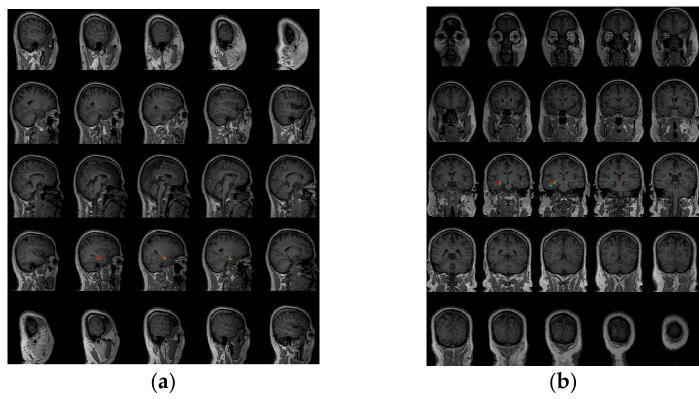
Figure 8. Source localization results for patient #2 based on a single spike using the proposed method, and the interpretation of subgraphs ( a , b ) was almost consistent with the subgraph interpretation of Figure 7.